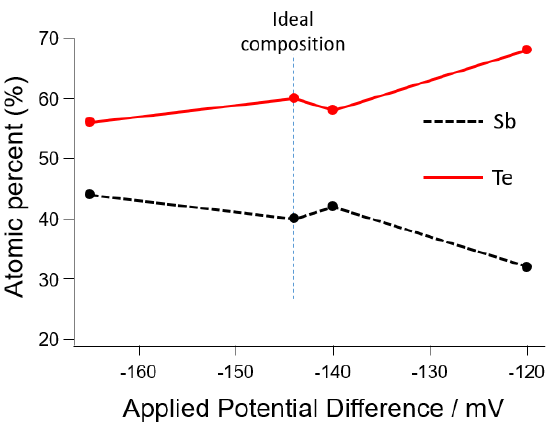
Figure 17. Potentials dependence on the atomic composition of the Sb 2 Te 3 .